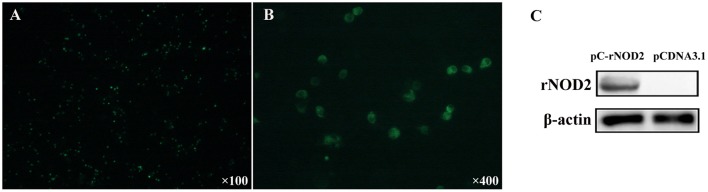
rNOD2 recombinant expression at protein level. The expression of rNOD2 protein in RK-13 cells was detected with immunofluorescence labeling. rNOD2 appears in green. Magnification was 100 × (A) and 400 × (B). (C) Immunoblotting of rNOD2 after transfected with pC-rNOD2. pCDNA3.1 (+) vector was used as control.